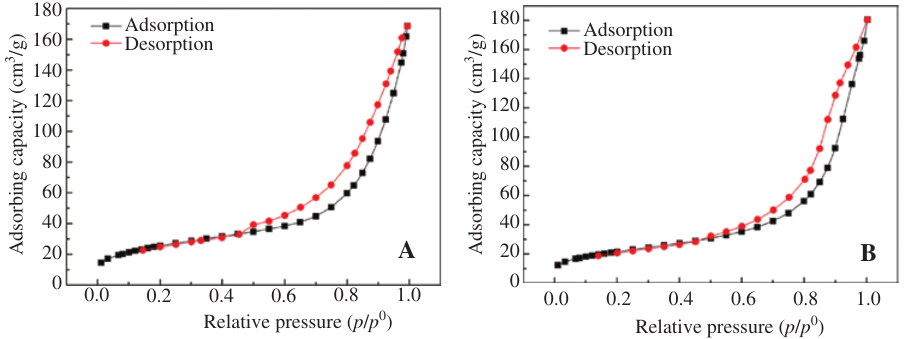
sorption isotherm curves of the alumina products (A) 700 ° C, (B) 900 ° Figure 3: N 2